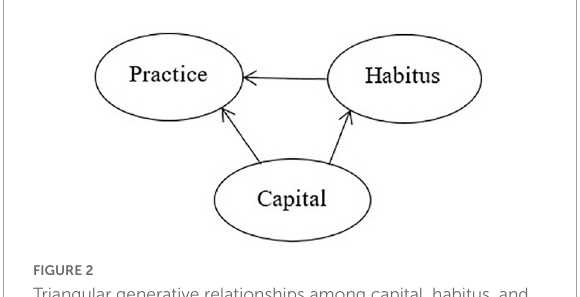
FIGURE2 Triangular generative relationships among capital, habitus, and